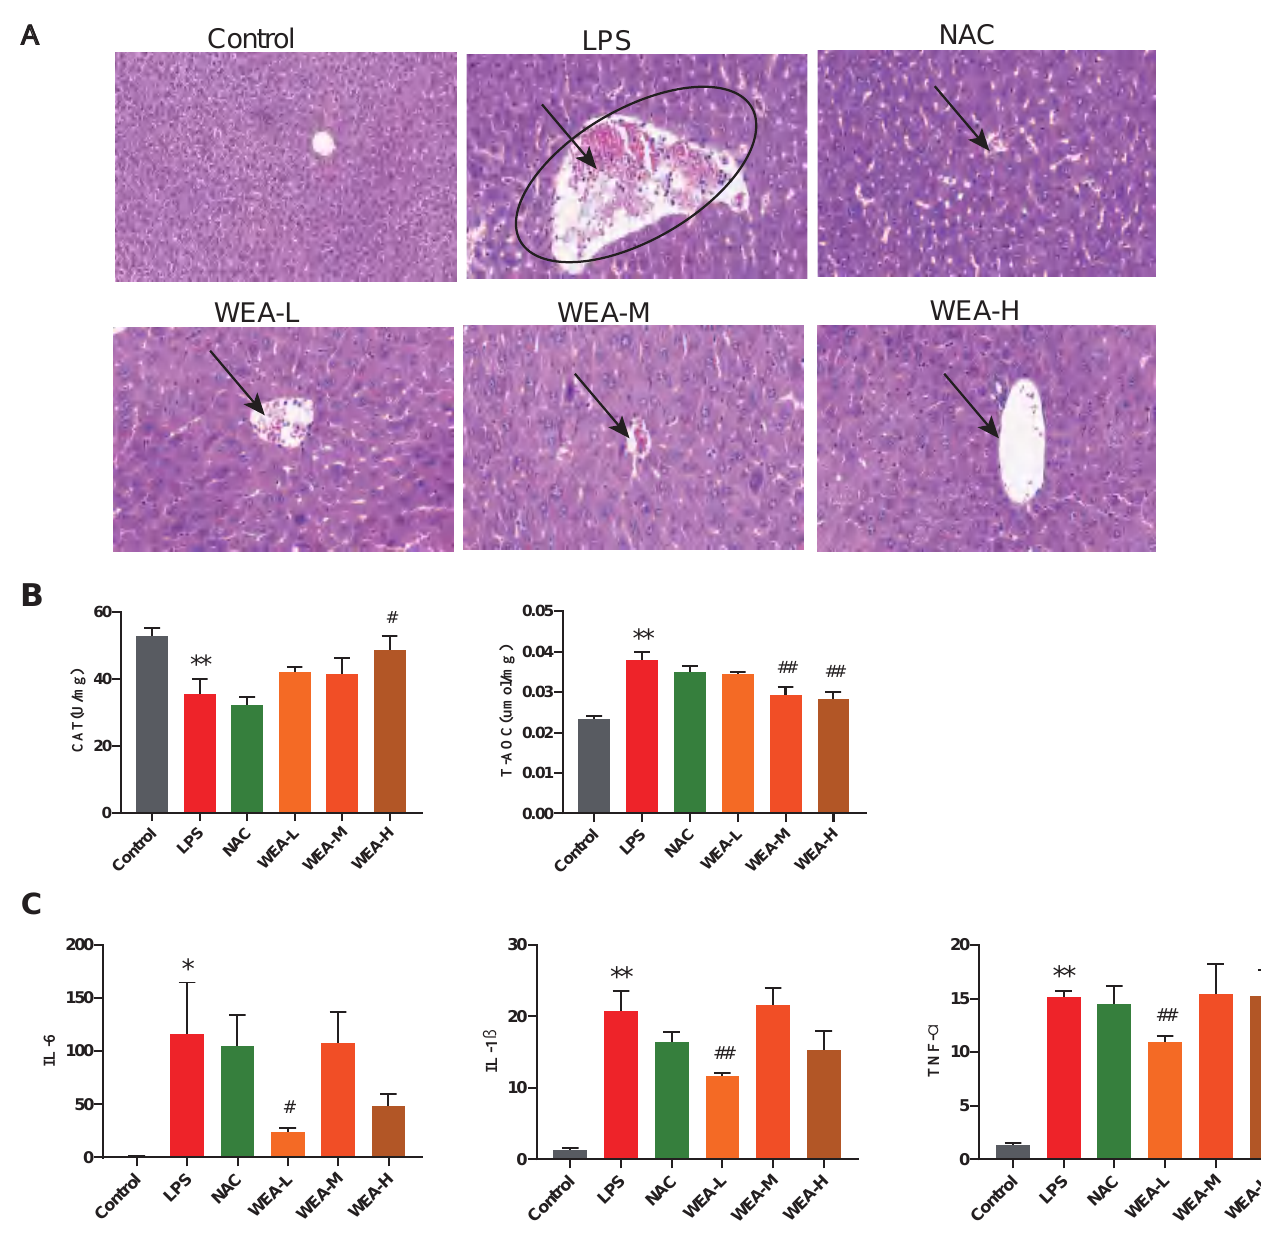
Figure 5. Liver morphology, antioxidant capacity, and inflammatory factor gene expression in